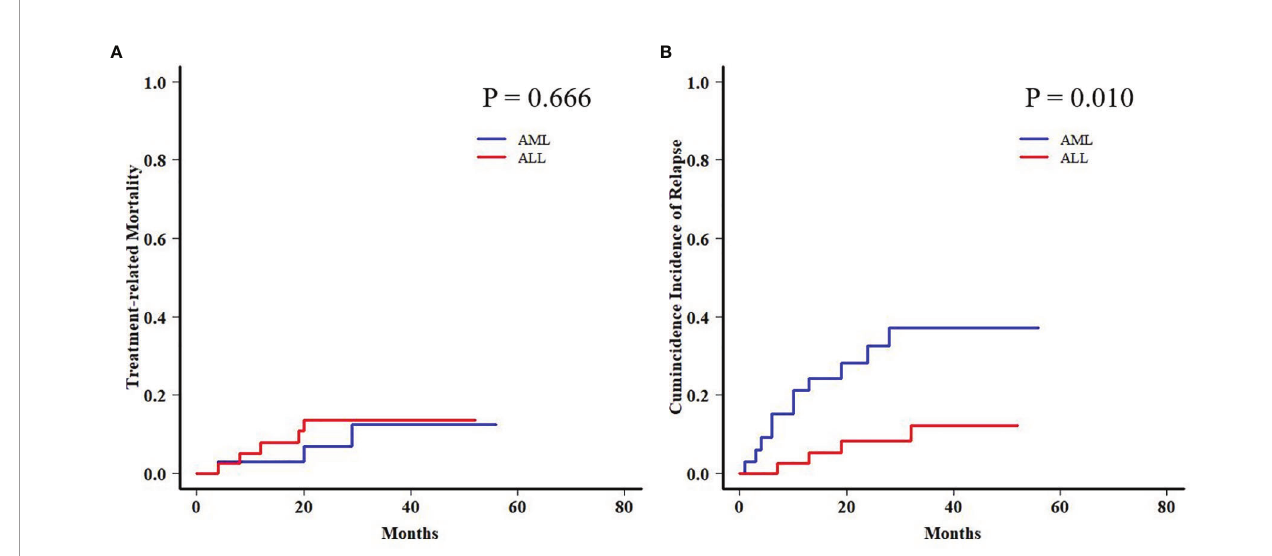
FIGURE 3 | Transplant outcomes between AML and ALL patients in the Epstein – Barr virus (EBV)+/cytomegalovirus (CMV) − subgroup. (A) TRM between AML and ALL patients in the EBV+/CMV − subgroup. (B) CIR between AML and ALL patients in the EBV+/CMV − subgroup.